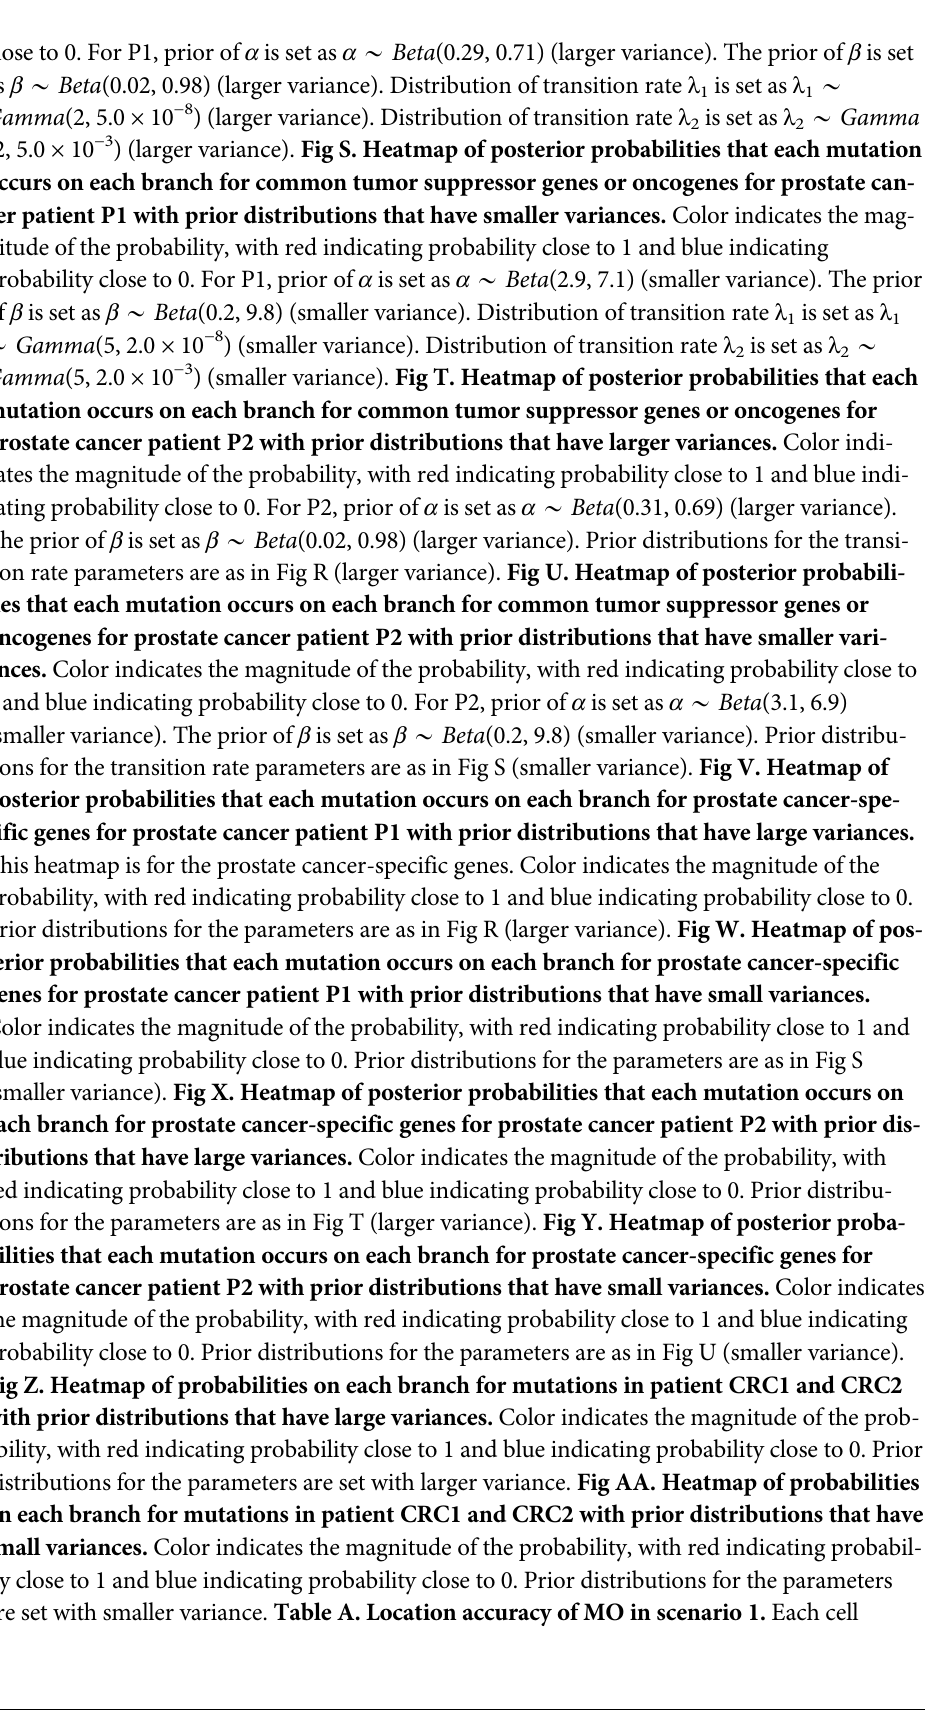
ances. Color indicates the magnitude of the probability, with red indicating probability close to 1 and blue indicating probability close to 0. For P2, prior of α is set as α * Beta (3.1, 6.9) (smaller variance). The prior of β is set as β * Beta (0.2, 9.8) (smaller variance). Prior distribu- tions for the transition rate parameters are as in Fig S (smaller variance). Fig V. Heatmap of posterior probabilities that each mutation occurs on each branch for prostate cancer-spe- cific genes for prostate cancer patient P1 with prior distributions that have large variances. This heatmap is for the prostate cancer-specific genes. Color indicates the magnitude of the probability, with red indicating probability close to 1 and blue indicating probability close to 0. Prior distributions for the parameters are as in Fig R (larger variance). Fig W. Heatmap of pos- terior probabilities that each mutation occurs on each branch for prostate cancer-specific genes for prostate cancer patient P1 with prior distributions that have small variances. Color indicates the magnitude of the probability, with red indicating probability close to 1 and blue indicating probability close to 0. Prior distributions for the parameters are as in Fig S (smaller variance). Fig X. Heatmap of posterior probabilities that each mutation occurs on each branch for prostate cancer-specific genes for prostate cancer patient P2 with prior dis- tributions that have large variances. Color indicates the magnitude of the probability, with red indicating probability close to 1 and blue indicating probability close to 0. Prior distribu- tions for the parameters are as in Fig T (larger variance). Fig Y. Heatmap of posterior proba- bilities that each mutation occurs on each branch for prostate cancer-specific genes for prostate cancer patient P2 with prior distributions that have small variances. Color indicates the magnitude of the probability, with red indicating probability close to 1 and blue indicating probability close to 0. Prior distributions for the parameters are as in Fig U (smaller variance). Fig Z. Heatmap of probabilities on each branch for mutations in patient CRC1 and CRC2 with prior distributions that have large variances. Color indicates the magnitude of the prob- ability, with red indicating probability close to 1 and blue indicating probability close to 0. Prior distributions for the parameters are set with larger variance. Fig AA. Heatmap of probabilities on each branch for mutations in patient CRC1 and CRC2 with prior distributions that have small variances. Color indicates the magnitude of the probability, with red indicating probabil- ity close to 1 and blue indicating probability close to 0. Prior distributions for the parameters are set with smaller variance. Table A. Location accuracy of MO in scenario 1. Each